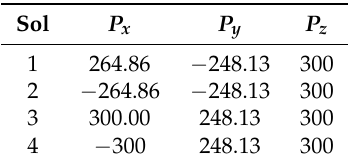
Table 2. Solutions of the forward position analysis, in mm.